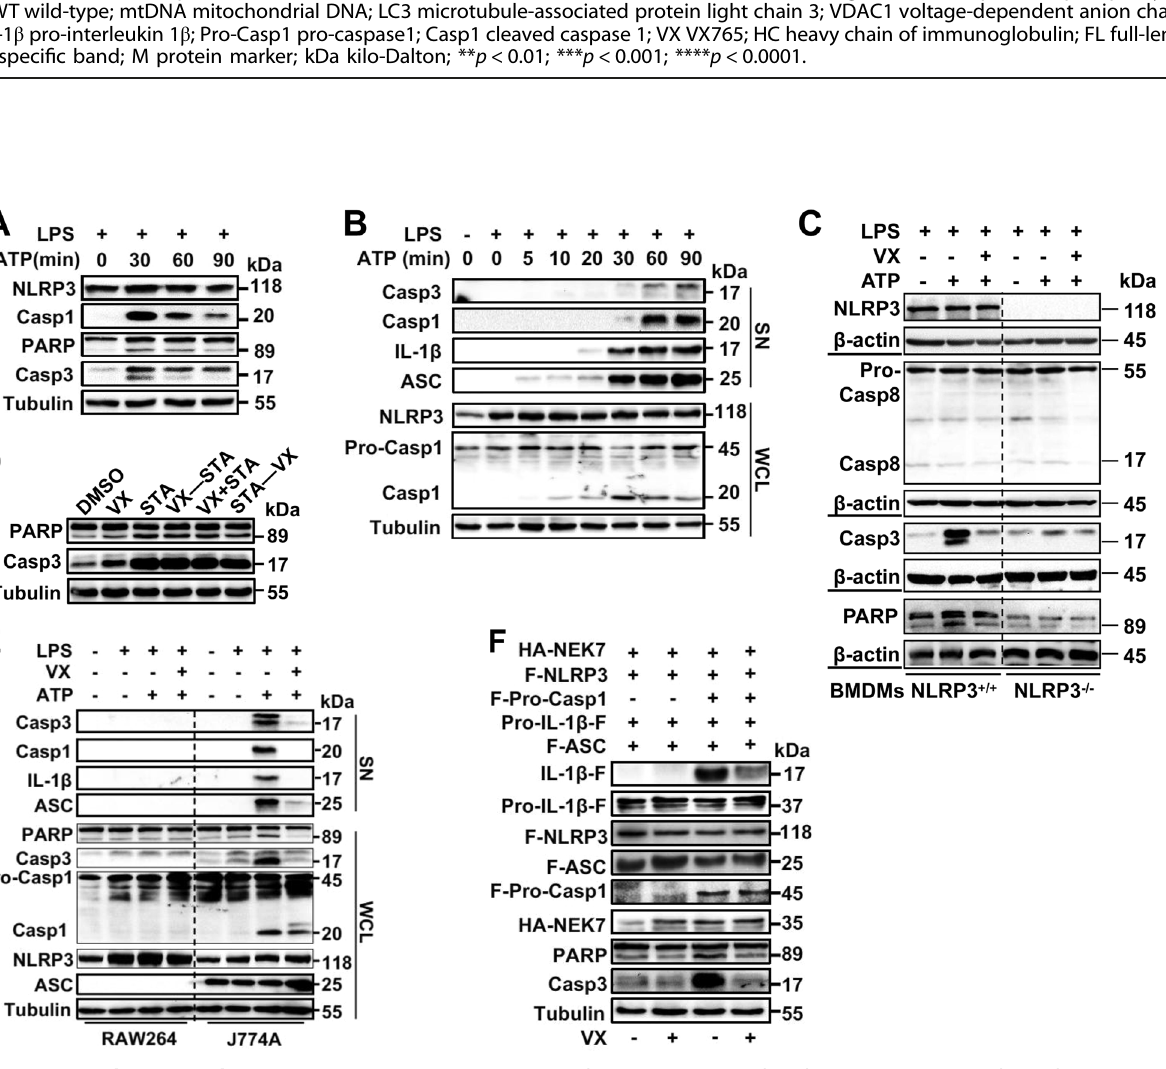
Fig. 2 NLRP3 in fl ammasome activation ampli fi es mitochondrial damage and blocks mitophagy. A , B J774A cells were treated without or with oxLDL (100 μ g/mL) ± VX765 (28 μ g/mL) for 24 h. The cells were then stained with the dichloro fl uorescin diacetate (DCFH-DA) and